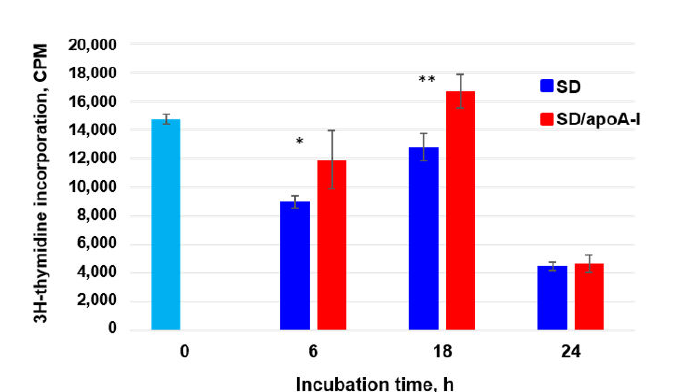
Figure 4. E ff ect of apoA-I on MSCs proliferation under condition of serum deprivation (SD) analyzed by 3H-thymidine incorporation assay. Light blue column—3H-thymidine incorporation under standard cultivation conditions (FBS + ). Data was shown as counts per minute (CPM) per well. * p ≤ 0.05, ** p ≤ 0.01 compared to SD and SD / apoA-I